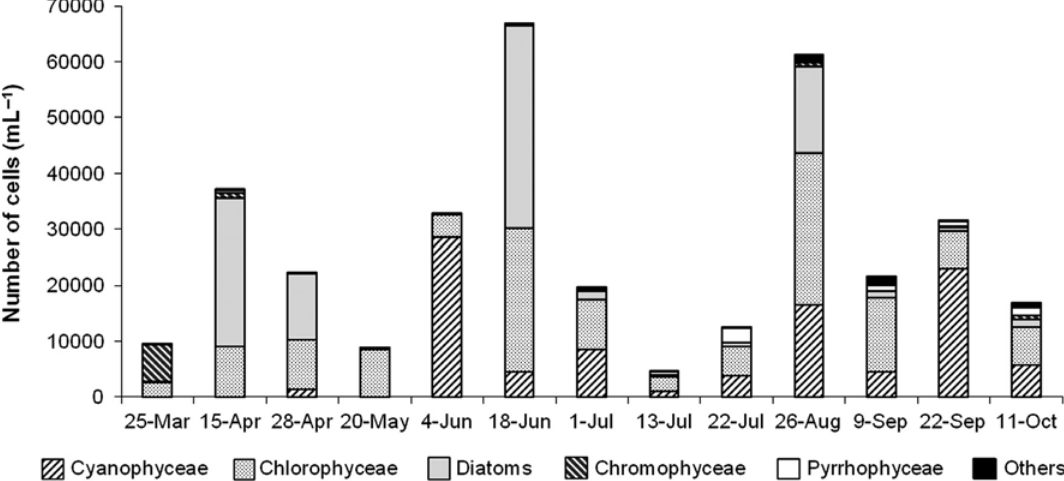
Fig. 4. Evolution of phytoplankton main groups in the overlying water of the Pont-Rouge Pond: Cyanophyceae , Chlorophyceae , Diatoms , Chromophyceae (without Diatoms ), Pyrrhophyceae and others (included Euglenophyceae and undetermined